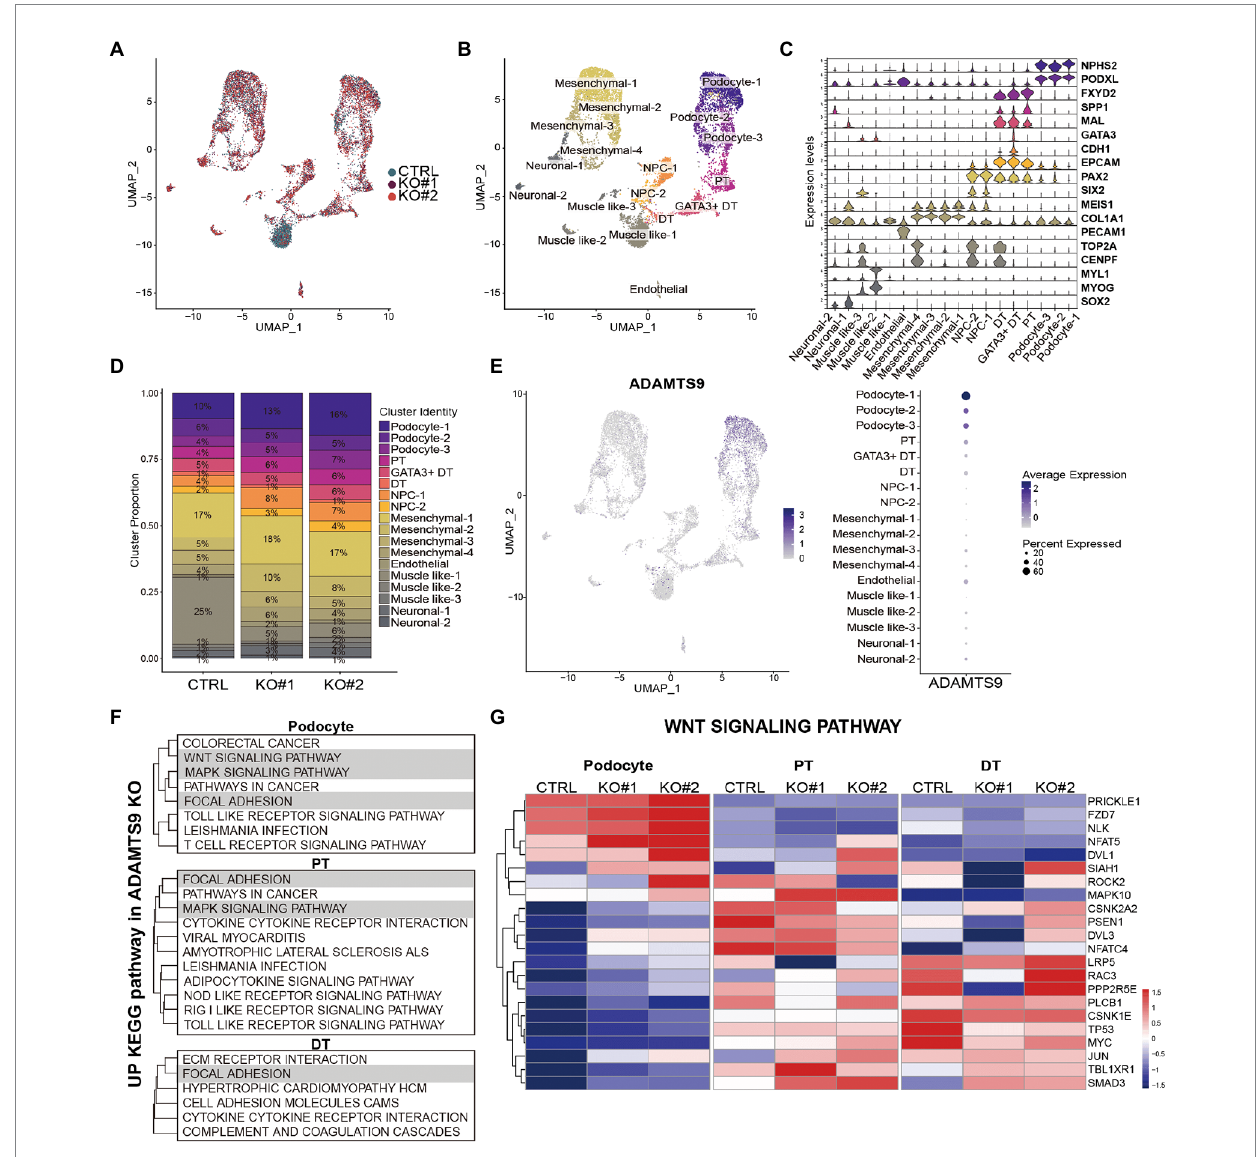
FIGURE 3 scRNA-seq analysis of the control and ADAMTS9 knockout kidney organoids. (A) UMAP visualization of single-cell transcriptomic profiles from two ADAMTS9 knockout organoids and a control organoid. (B) UMAP plots showing 18 clusters identified by canonical marker genes. (C) Proportion of clusters across control and ADAMTS9 knockout organoids with corresponding percentages. (D) Violin plots showing the expression of canonical and data-derived kidney markers used to identify nephron clusters in D29 organoids: podocytes (NPHS2, PODXL), proximal tubules (FXYD2, SPP1), distal tubules (MAL, CDH1), immature distal nephrons (GATA3 + DT), and nephron progenitor cells (PAX2, SIX2). Mesenchymal, endothelial, and off-target cells were also identified. (E) ADAMTS9 expression across all clusters in control organoids. (F) Analysis of leading edge genes from GSEA of differentially expressed genes in podocytes, PT, and DT clusters showed three enriched pathways: focal adhesion, MAPK pathway, and Wnt pathway. (G) Heatmap showing expression of Wnt signaling pathway-related genes identified by GSEA in podocytes, PT, and DT clusters in control versus ADAMTS9 knockout kidney